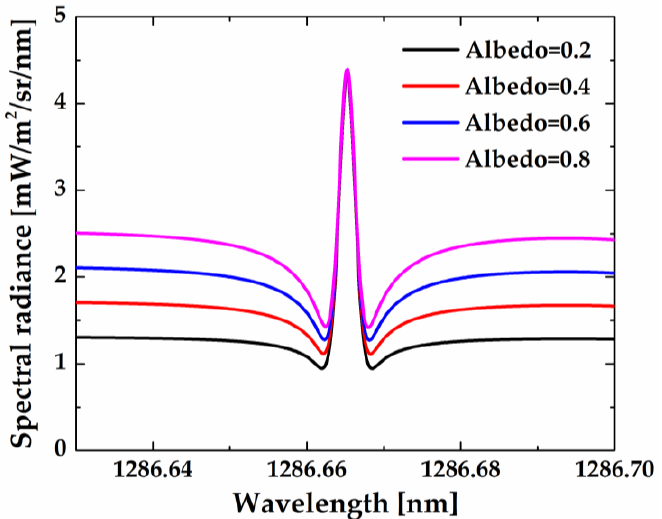
Figure 13. The line shape of the total spectral brightness as a function of albedos at the tangent height of 15 km.